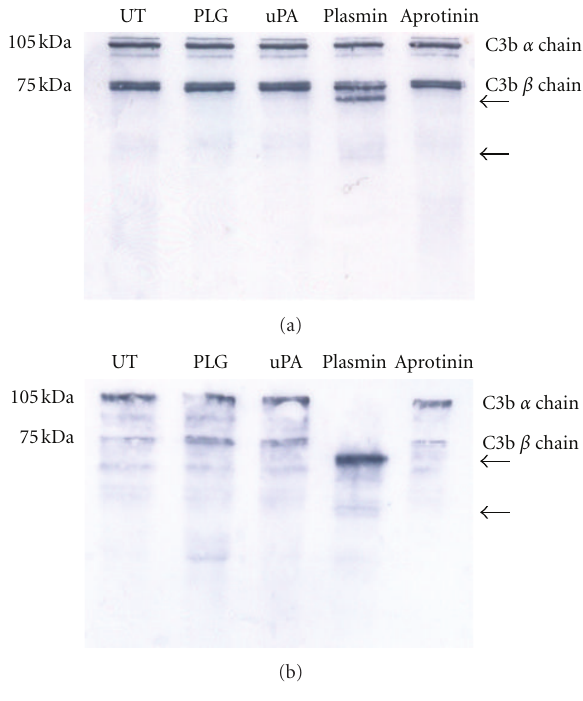
Figure 12: Detection of human C3b. Leptospires (10 8 /sample) were treated with 10 μ g PLG and 3U uPA (Plasmin), only with PLG (PLG), or left untreated (UT). The cells were incubated with 15 μ g/mL human purified C3b for 20h at 37 ◦ C, and the supernatants were resolved by SDS-PAGE and transferred to membranes. The C3b was detected by specific antibodies followed by ECL reagent development and exposition to X-Ray films. There are indicated the native human C3b alpha chain (105KDa) and beta-chain (75KDa), as well as the degradation products